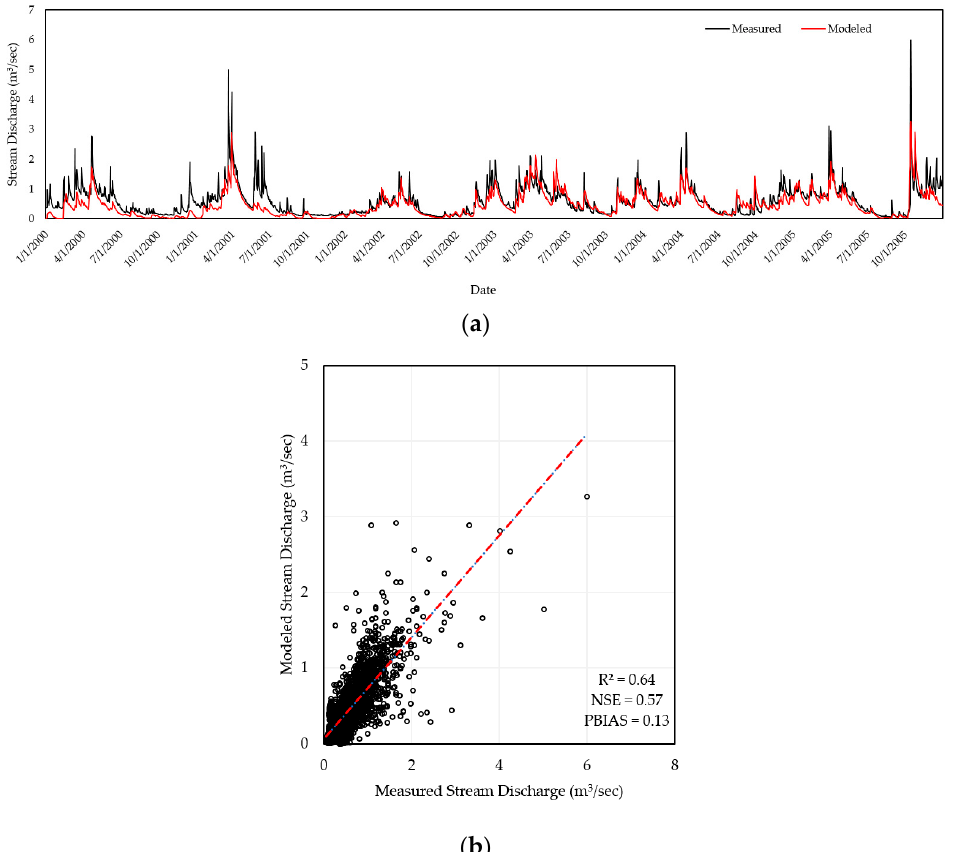
Figure 2. ( a ) Hydrograph and ( b ) scatterplot of observed versus SWAT modeled streamflow at Beaver River USGS gauge 01117468 during calibration years 2000–2005.